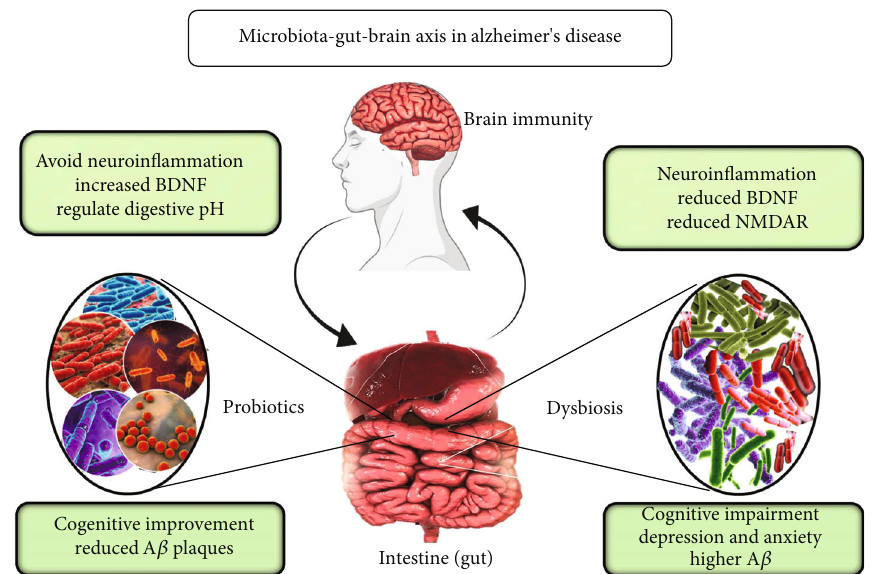
Figure 2: Crosstalk between the gut microbiome and the brain in Alzheimer ’ s disease. Metabolic, endocrine, neurological, and immunological communication routes exist between the gut microbiota and the brain, and they can act independently or 3.3. Amyotrophic Lateral Sclerosis. Amyotrophic lateral scle-